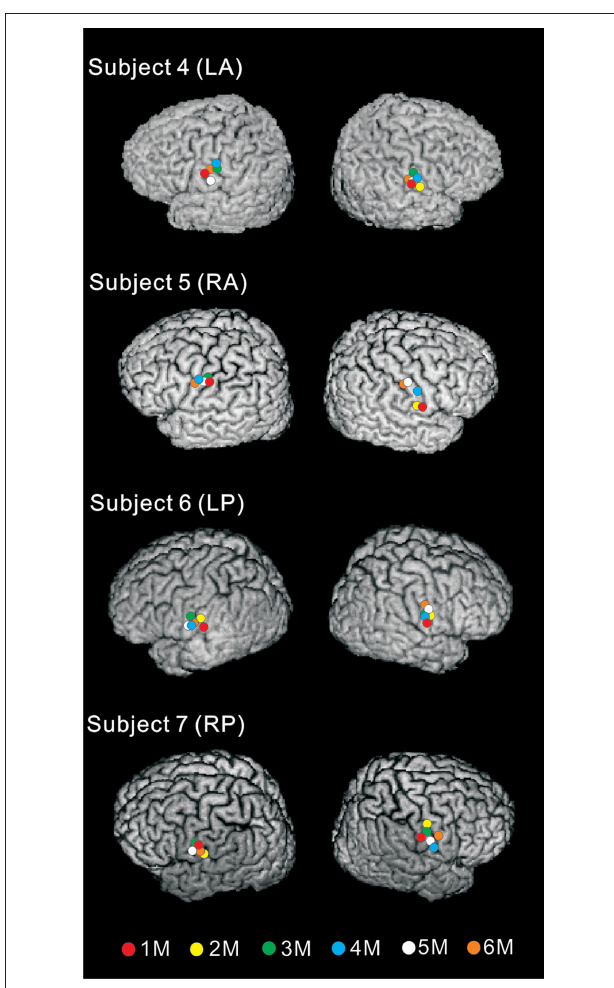
FIGuRE 3 | Equivalent current dipoles (ECDs) on 3D images of four representative subjects. These ECDs were estimated to lie around the posterior wall of the central sulcus, corresponding to the tongue SI. Red, yellow, green, blue, white, and orange circles indicate the ECDs of 1M, 2M, 3M, 4M, 5M, and 6M, respectively. Adopted from Sakamoto et al.